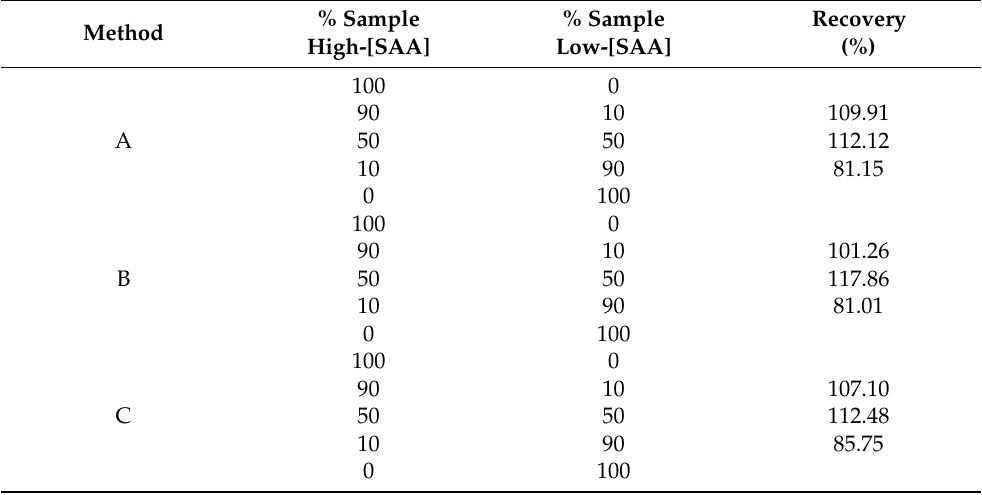
Table 2. Recovery of SAA after mixing in different proportions two samples with high and low con- centrations of serum amyloid A (SAA) with Fujifilm (method A), Eurolyser Diagnostica (method B) and Eiken (method